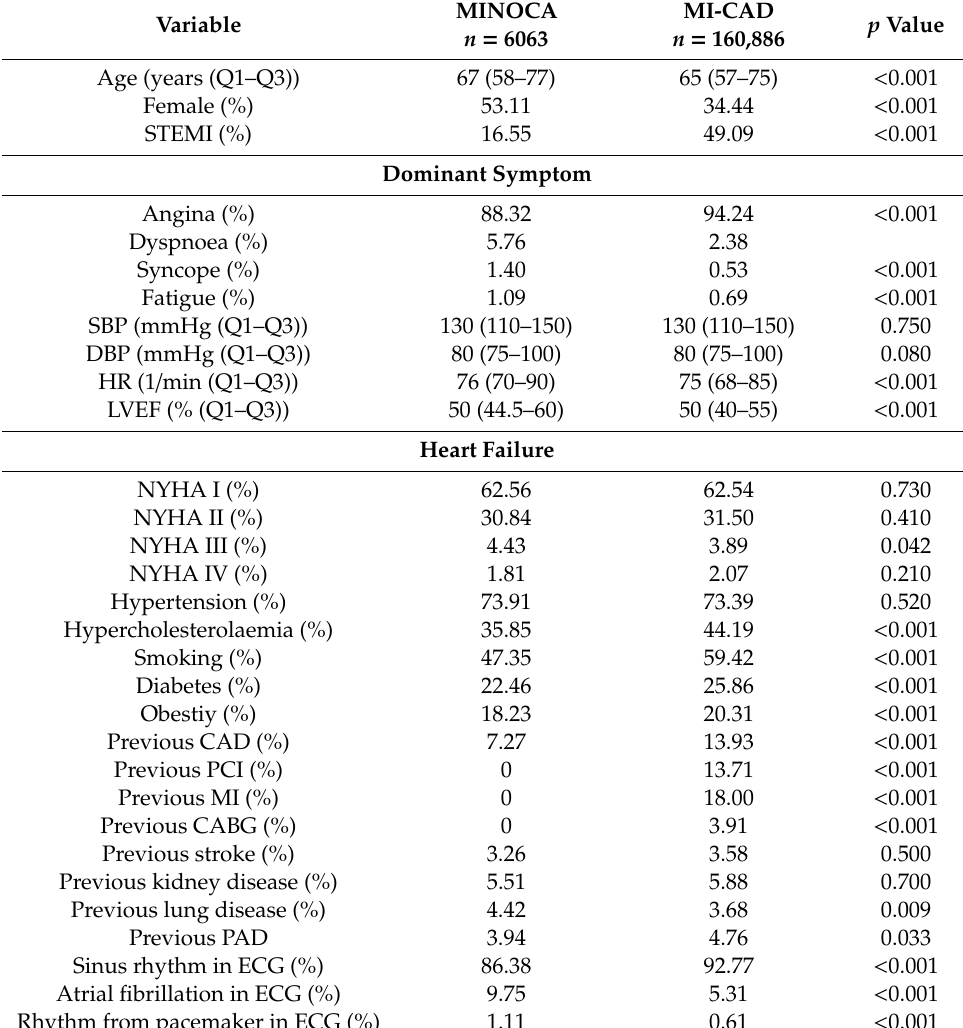
Table 2. Baseline